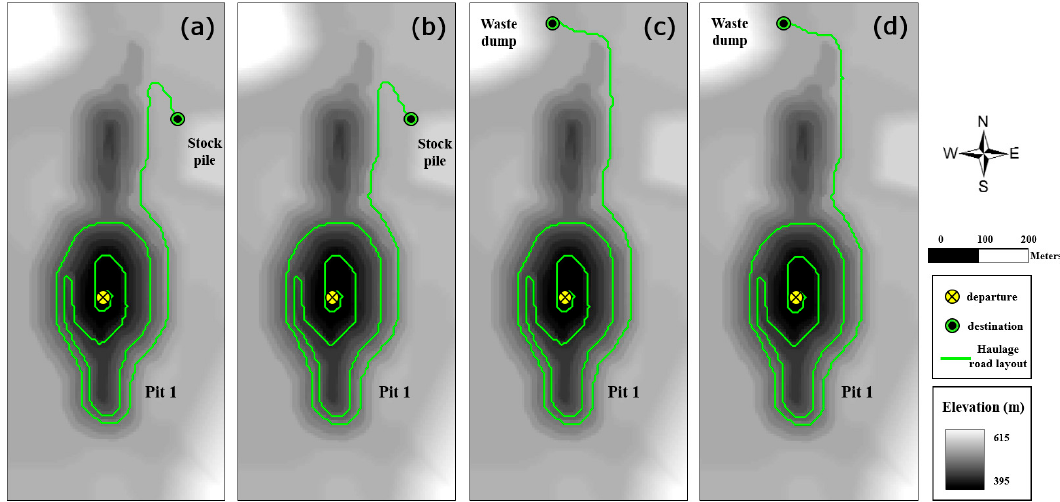
Fig 1. Figure 18. Result of analyzing the road layout based on the 3D terrain model shown in Figure 17, obtained using LCPA. The paths connect the loading point in Pit 1 with the stockpile when the truck moves ( a ) uphill and ( b ) downhill and also connect the loading point in Pit 1 with the waste dump when the truck moves ( c ) uphill and ( d ) downhill.